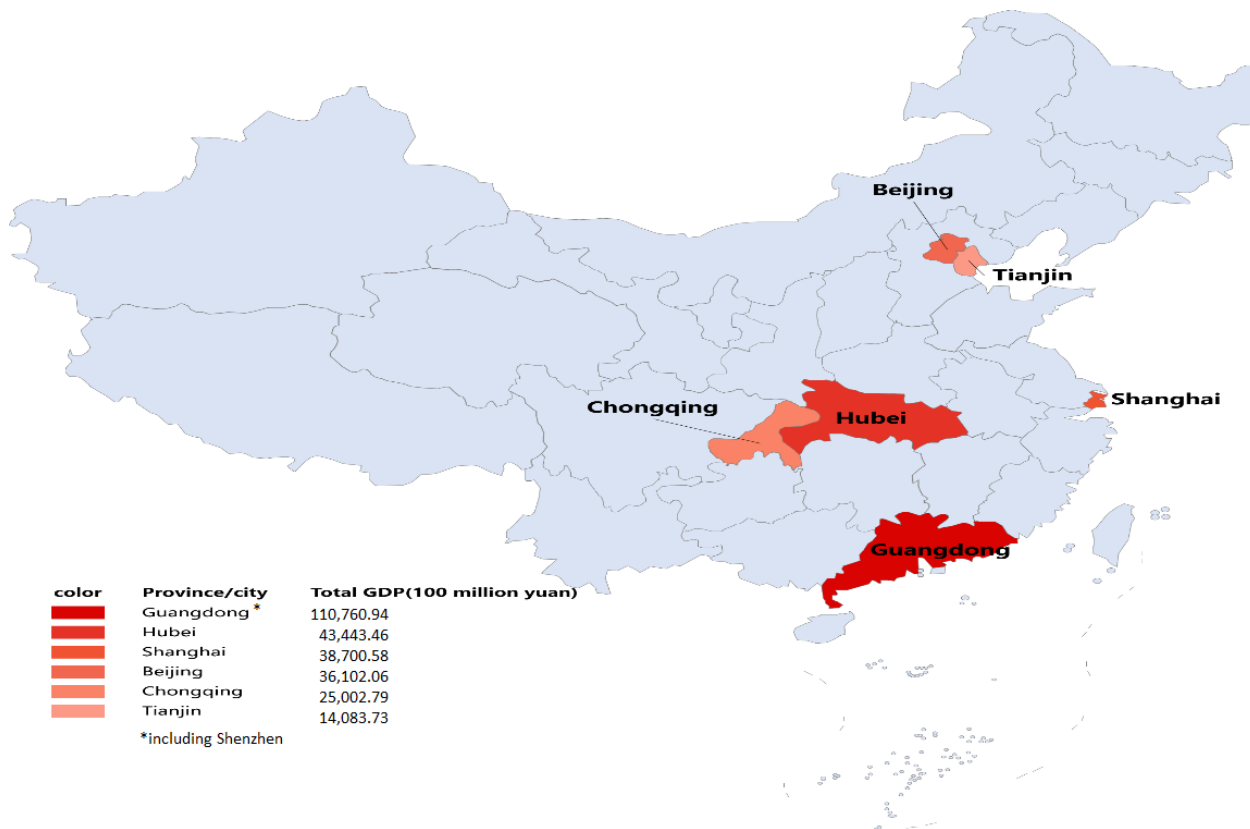
Figure 1. Spatial distribution of all seven pilot cities for ETS in China.